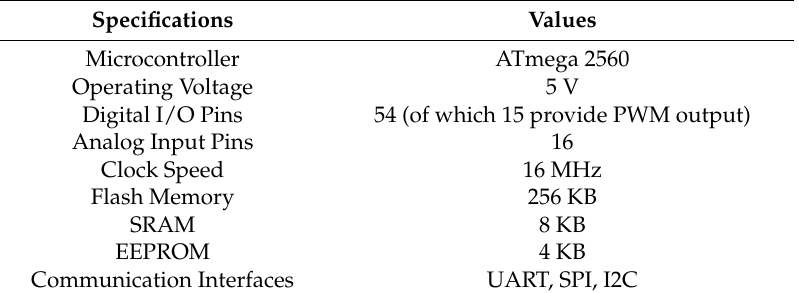
Table 1. Arduino Mega specifications.